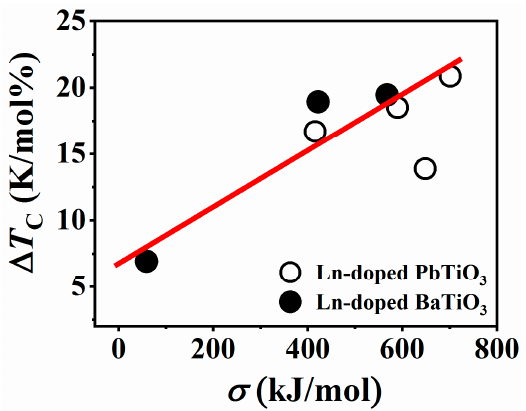
Figure 5. The decrease rate of T C ( ∆ T C ) with the bond strengths variance of A-site cation ( σ ) based on the Tables S3 and S5.